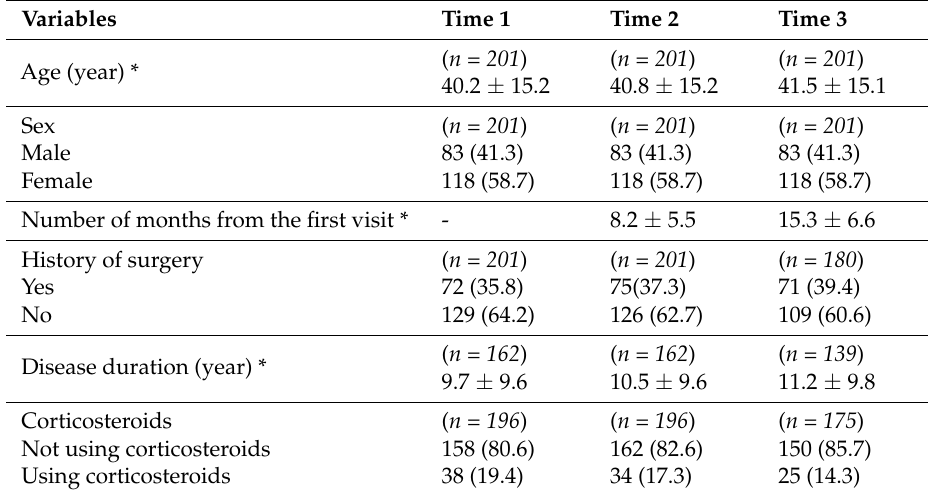
Table 2. Descriptive Characteristics for the Retrospective Cohort Data Demographics, Disease Duration, Surgery and Corticosteroids